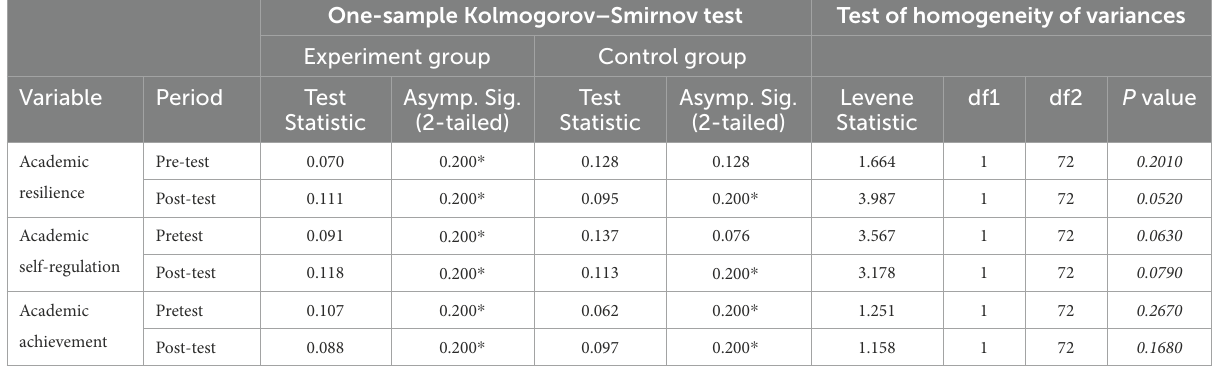
TABLE 2 Kolmogorov–Smirnov test (K-S) for pre-test and post-test of control and experimental